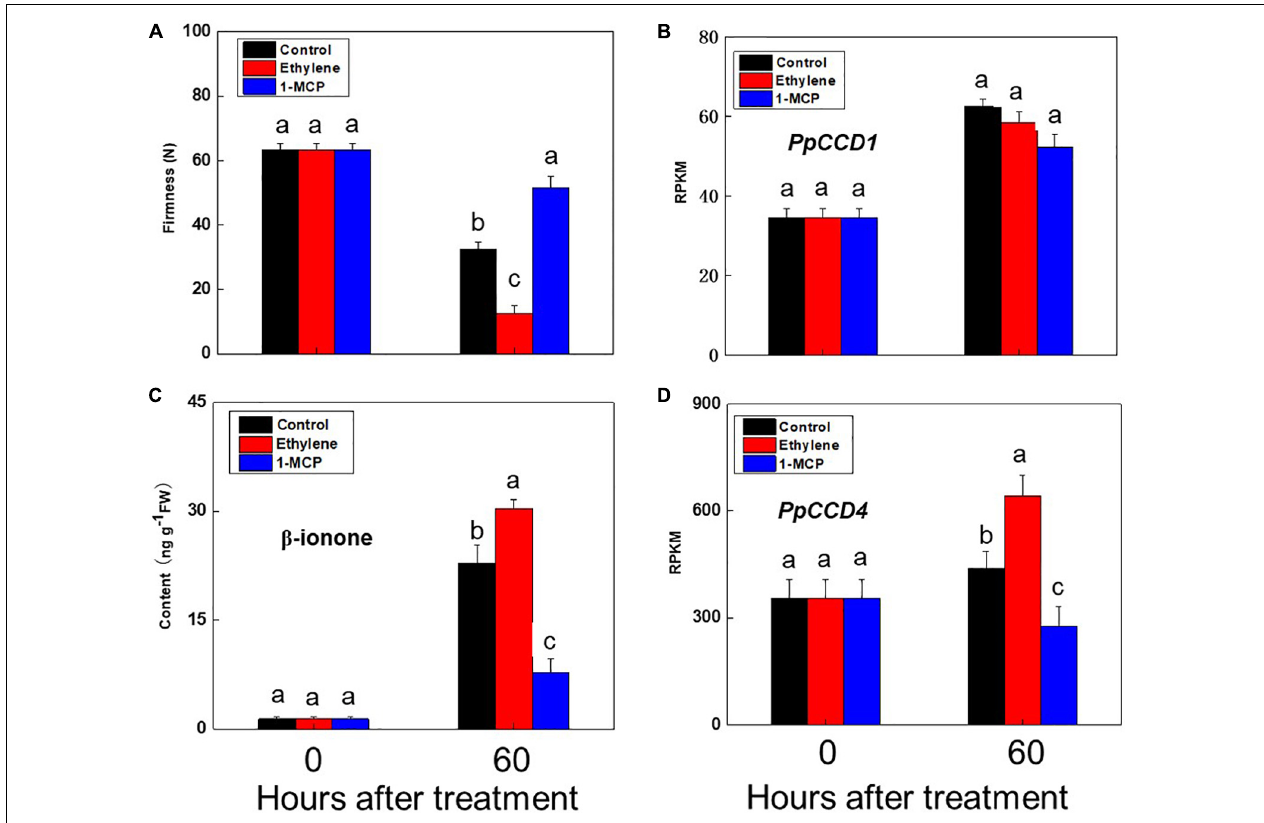
FIGURE 2 | Change of β -ionone content and PpCCDs transcript levels after ethylene and 1-MCP treatments. (A) Change of the firmness. (B) Transcript level of PpCCD1. (C) Content of β -ionone. (D) Transcript level of PpCCD4 . The fruits were suffocated with 12 h and then stored at room temperature for 60 h. Different letters indicate the significant difference between the two columns ( p <